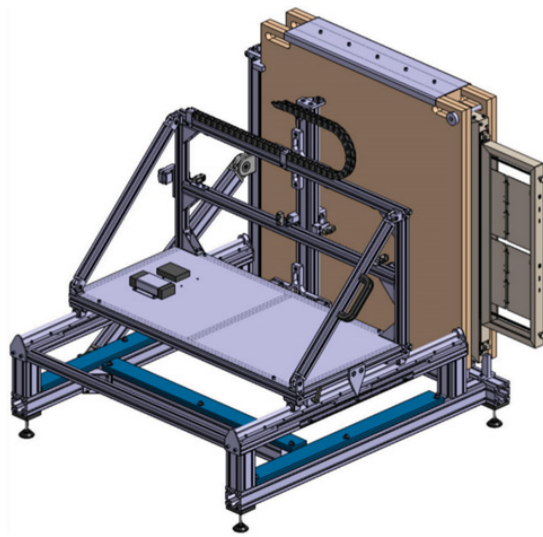
Figure 9. Diagram of the CALIPSO system for calibration of the SoLid planes, which operates in neutron and gamma mode.